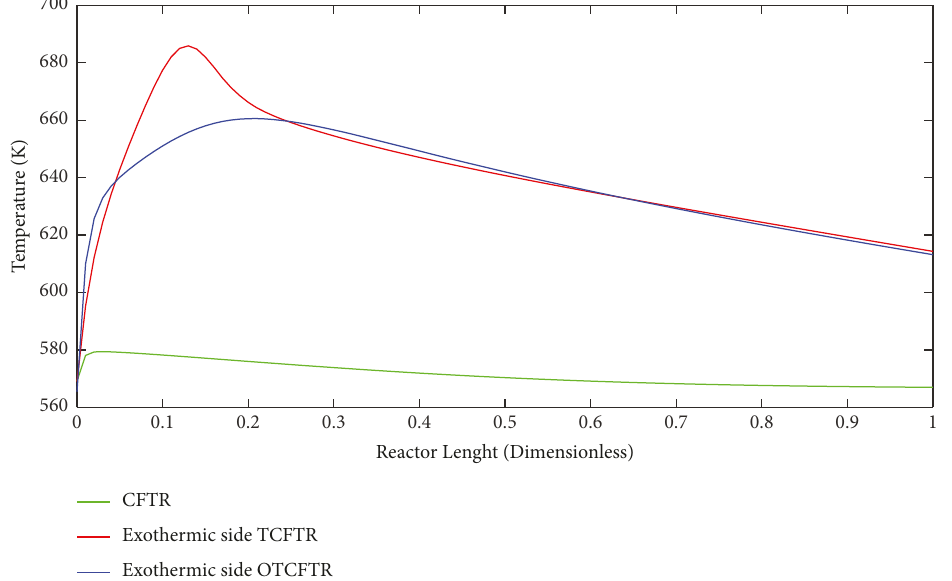
Figure 25: Comparison of temperature profiles in different states of the exothermic section along the reactor